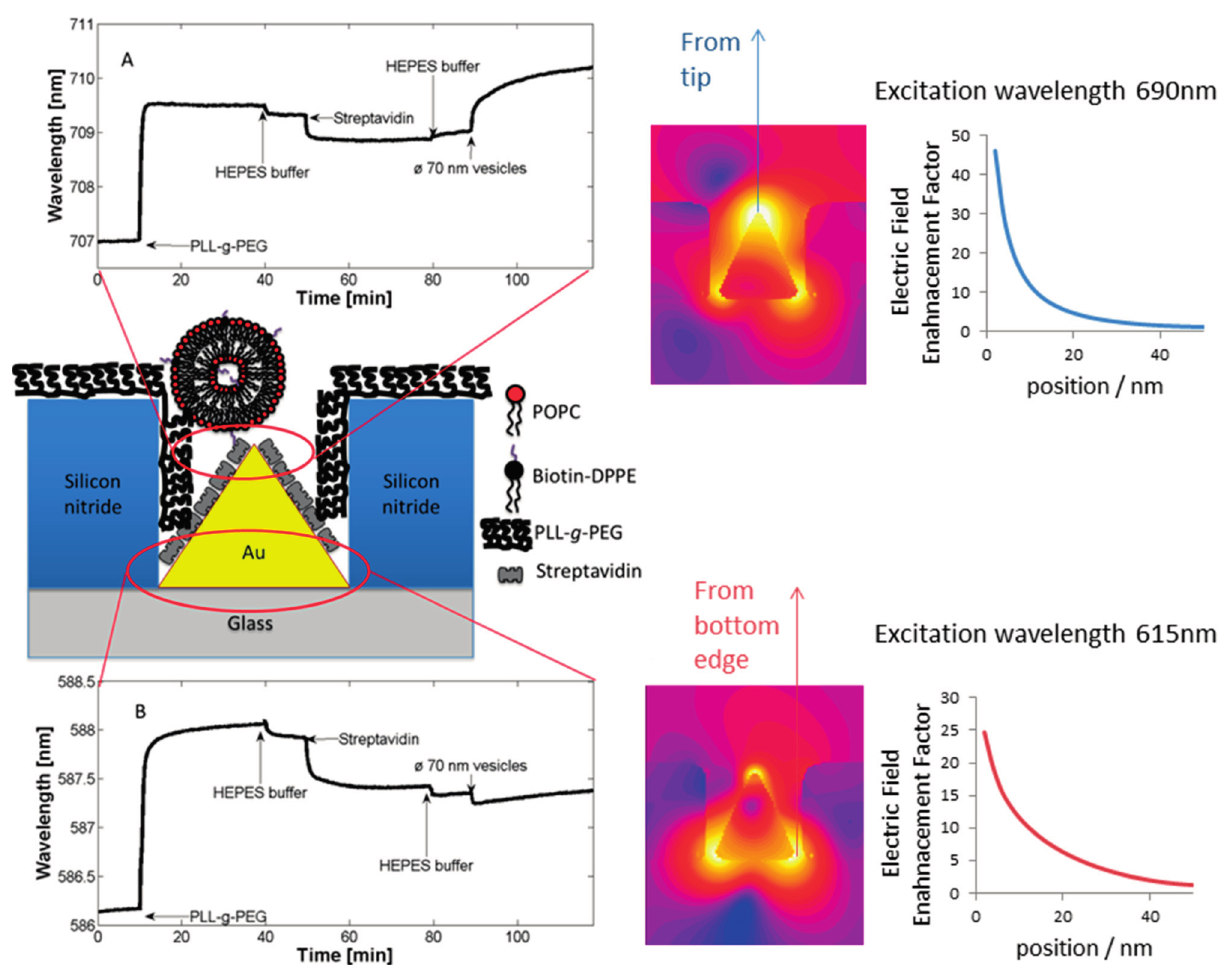
Figure 2. Example of the higher sensitivity at the edges of nanoplasmonic sensor elements. A 100-nm gold cone embedded in a nanocavity display the highest enhancement and measurement sensitivity at the base and the apex. The geometry was used to selectively measure molecules interacting only at the tip or at the base of the sensor element [38]. ( A ) Shows the sensor response at the apex and ( B ) shows the sensor response at the base. Simulations (right) show the highly localized electric field enhancement that explains the localized